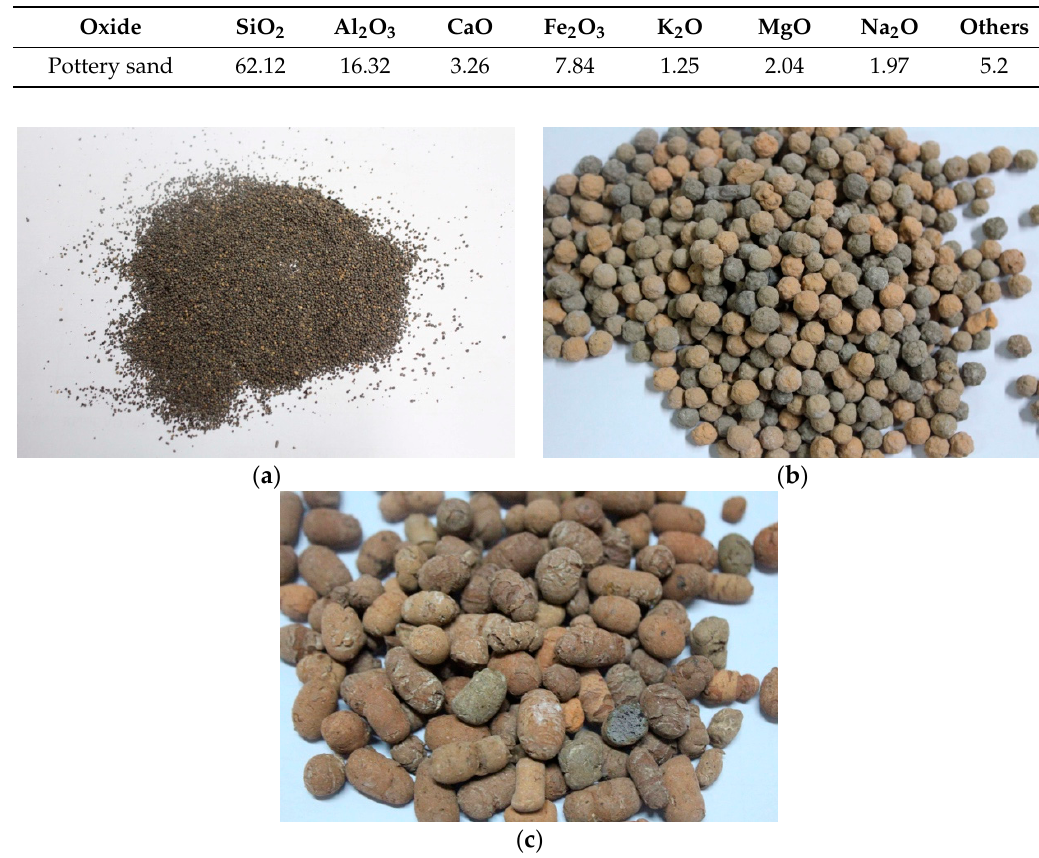
Figure 2. Images of ( a ) pottery sand; ( b ) 5–10 mm ceramsite; ( c ) 10–16 mm